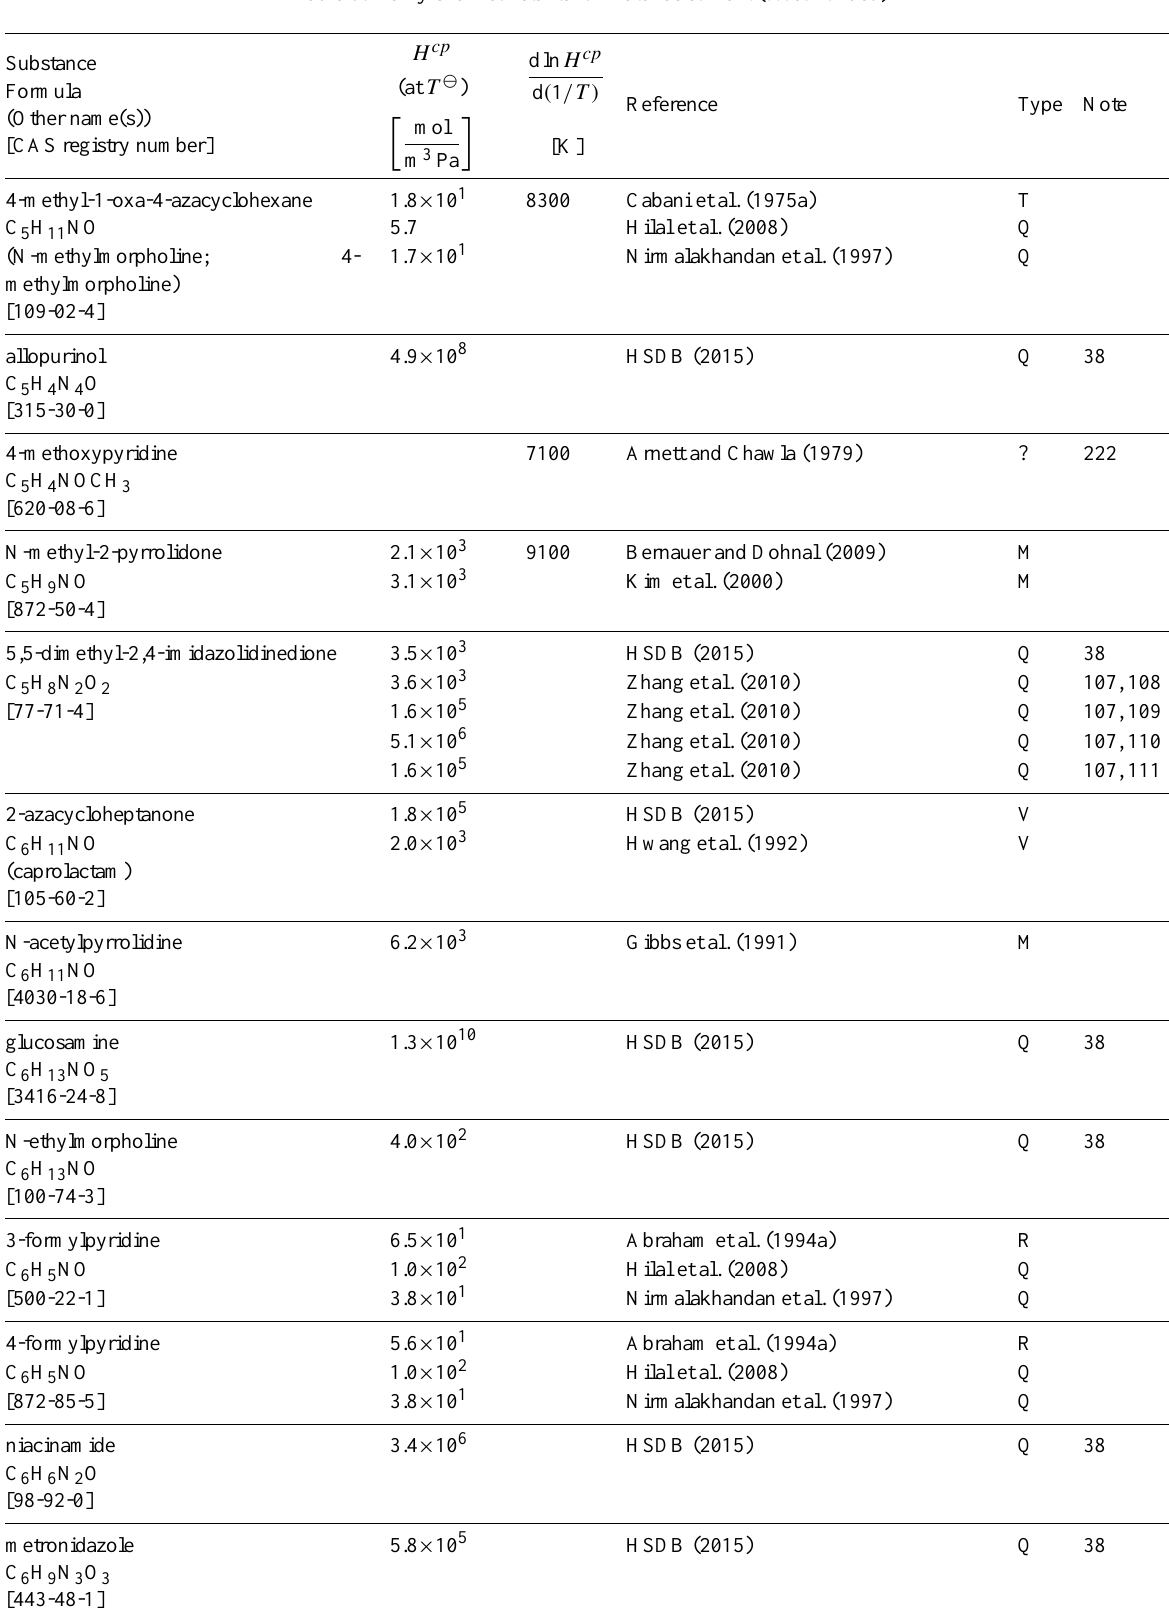
Table 6: Henry’s law constants for water as solvent